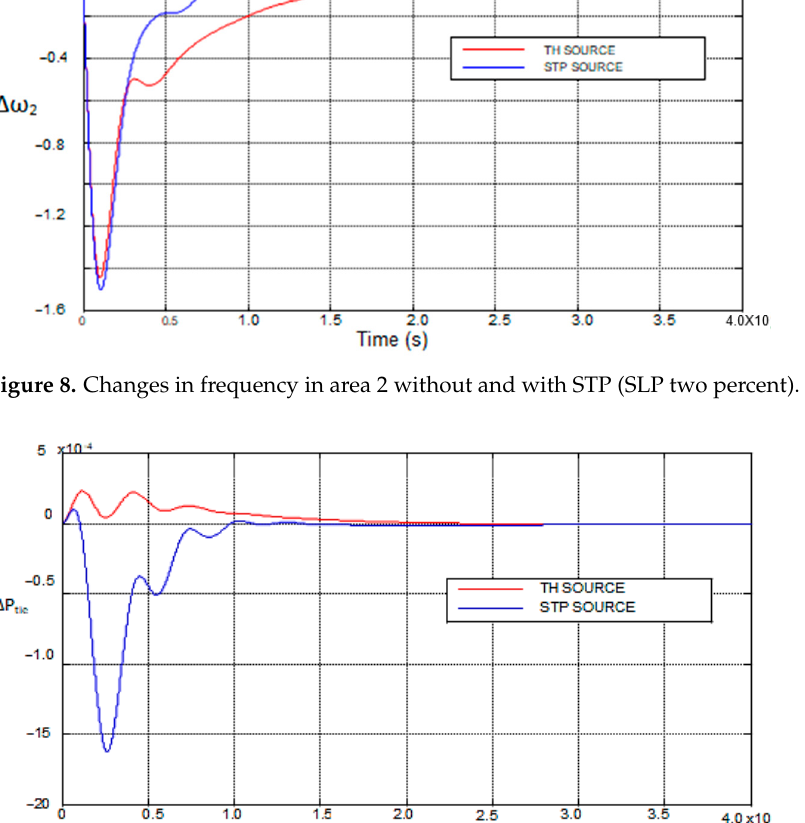
Figure 9. Power flow in tie line without and with STP (SLP two percent).